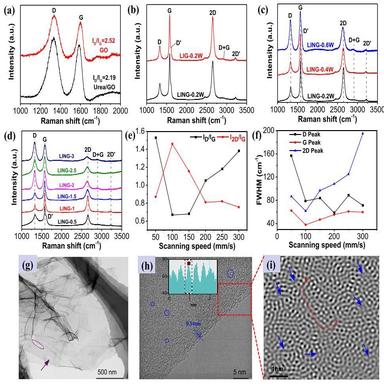
(a) Raman spectra of GO and GO/urea films. (b) Raman spectra of LIG-0.2W and LING-0.2W films. (c) Raman spectra of LING-0.4W and LING-0.6W films. (d) Raman spectra of LING films obtained at different scanning speed of 0.2W power. The spectra are normalized with respect to G peak intensity. (eef) ID/IG ratios, I2D/IG ratios and FWHM value of LING films obtained at different scanning speed of 0.2W power. (g) TEM and (h) HRTEM images of the LING-0.2W flakes. (i) Inverse FFT images from the region indicated by